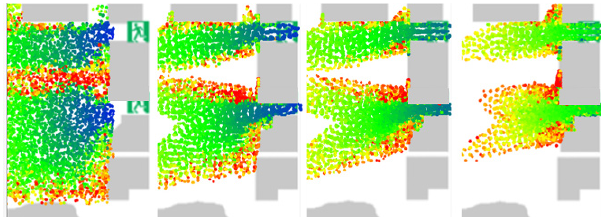
Fig. 27 Clogging behaviour in the island example. Agents are color- coded for tracking. Left to right: snapshots at frames 0, 500, 1000, and 2000. Although some red agents were near the exits, they took longer to reach the exits, because the roads were filled with moving agents preventing these red agents from moving to the